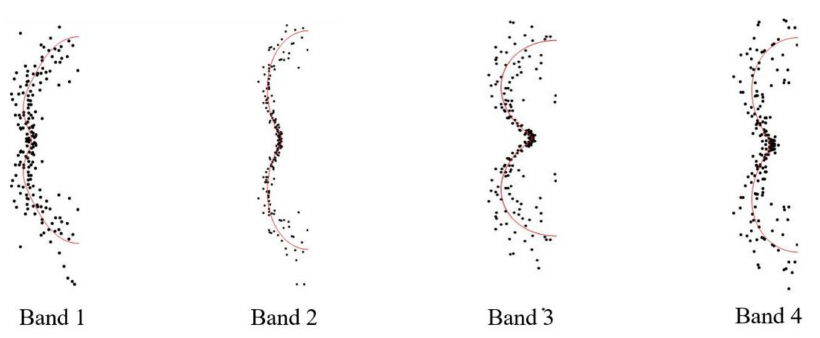
Figure 5. Photoelectron spectral and corresponding angular